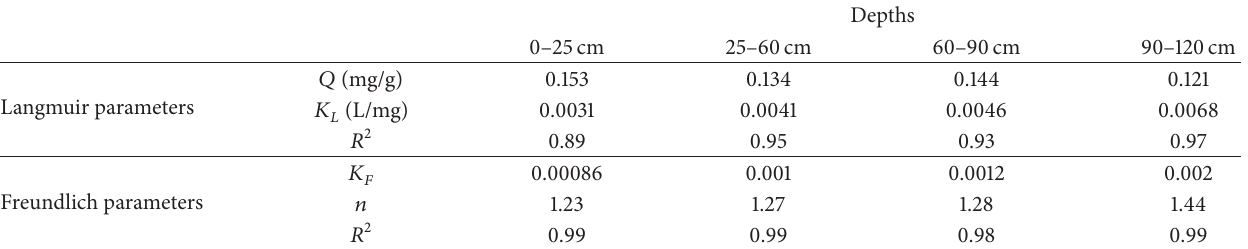
Figure 3: Effect of initial NO 3− concentration on NO 3− sorption for 4 soil depths from a batch experiment using an iso-humic soil from Chott Meriam, Tunisia (25, 50, 75, 100, 125, and 150mg L −1 , 22 ∘ C, 24h, and soil mass = 5g). Table 2: Langmuir and Freundlich parameters for sorption of NO 3− on four depths of iso-humic soil from Chott Mariam, Tunisia.